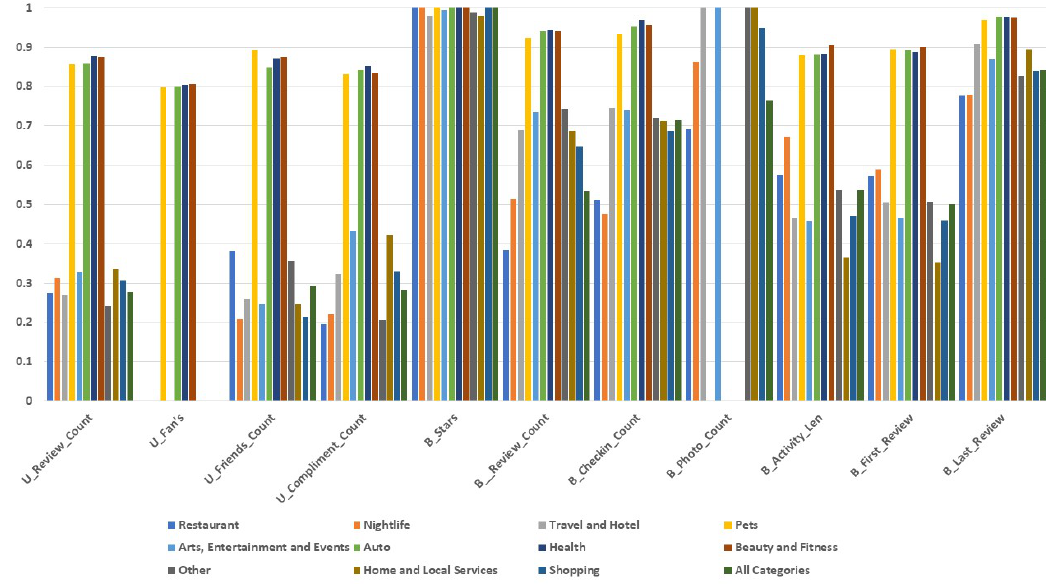
Figure 8. The importance of each feature for all